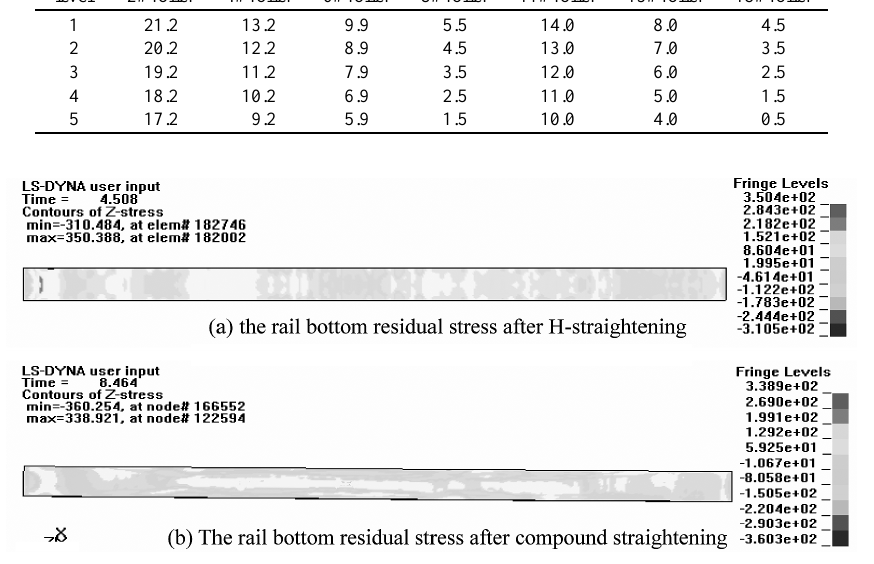
Fig. 9. The residual stress of rail bottom.